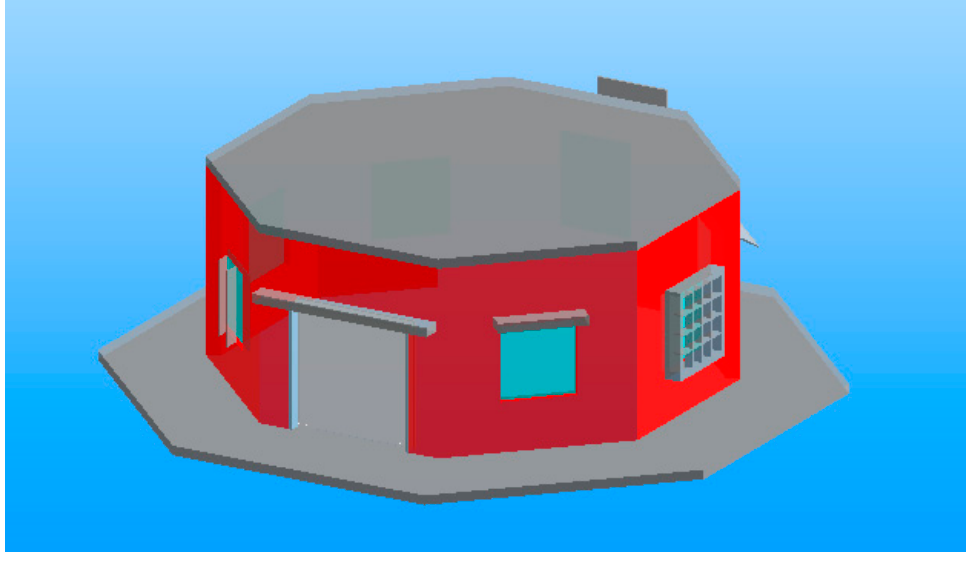
Figure 12. Example model.